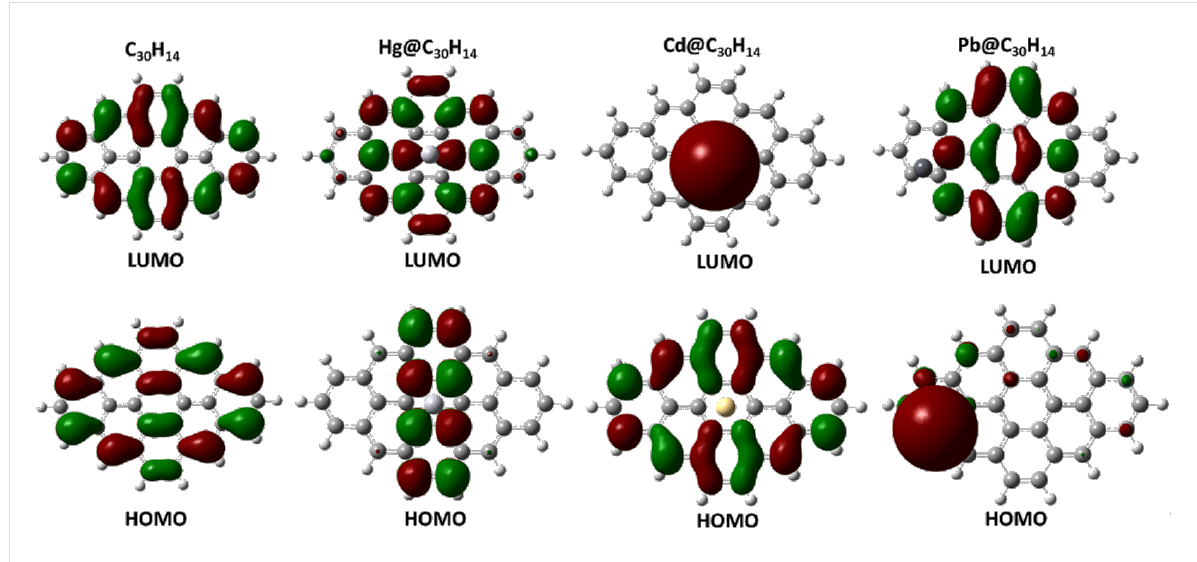
Figure 5: Isosurfaces of the molecular orbitals of the pristine C 30 H 14 cluster before and after interaction with heavy